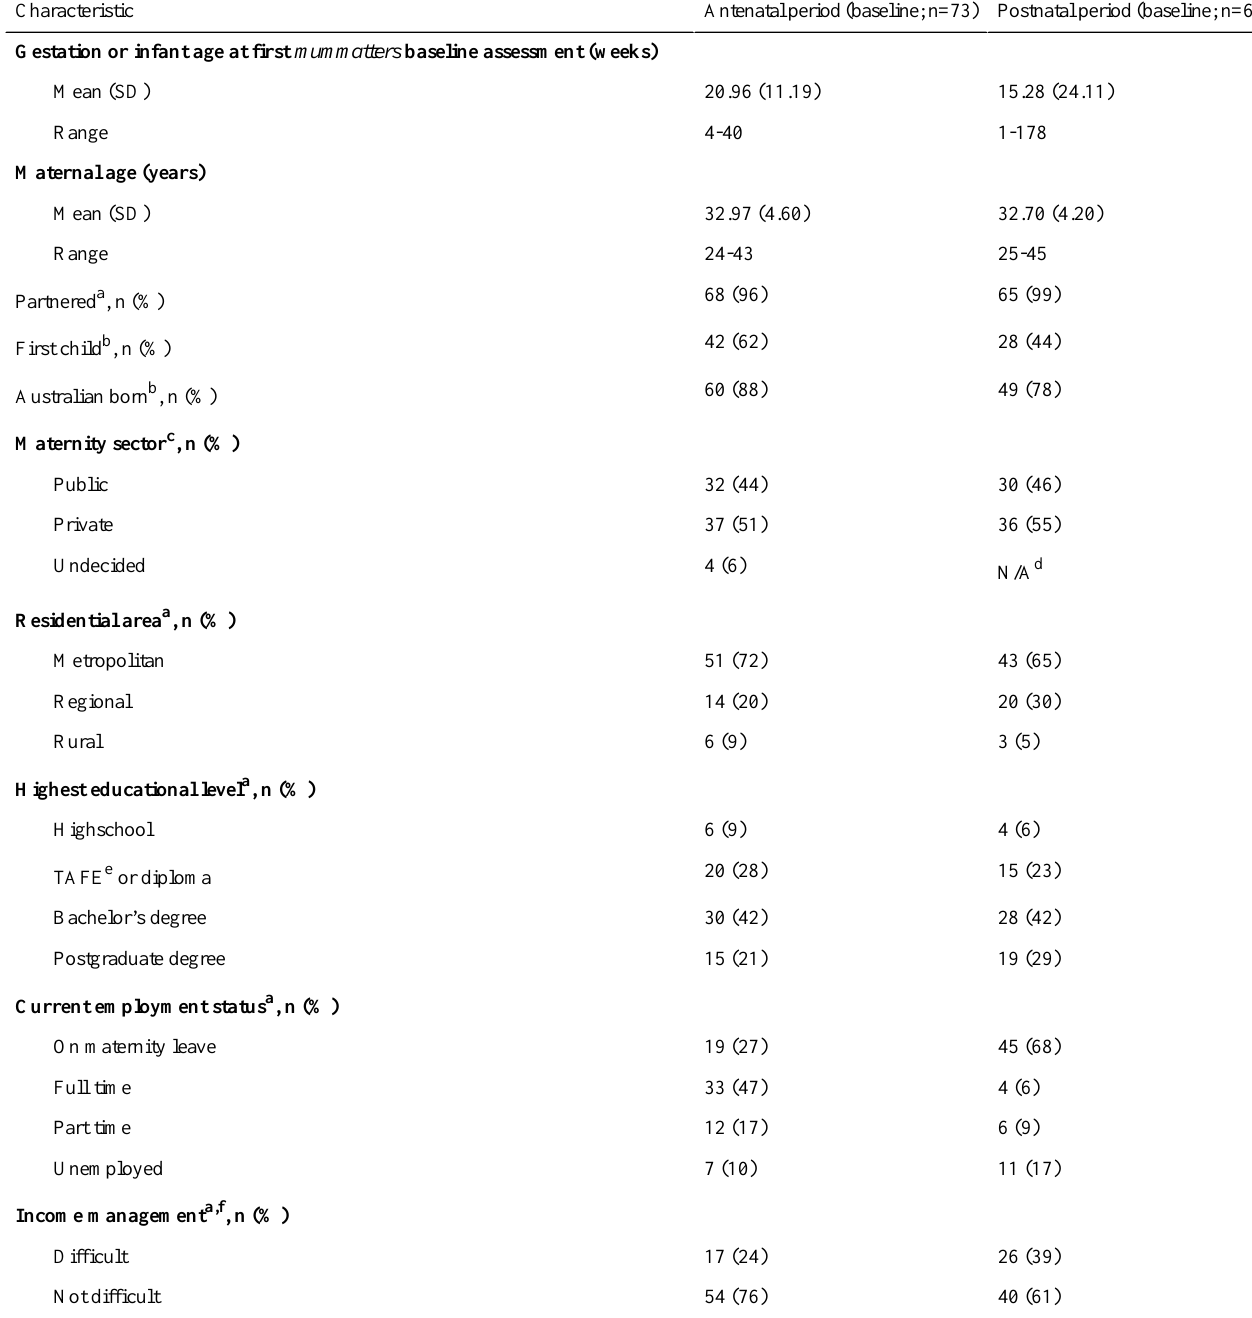
Table 1. Sociodemographic characteristics of mummatters evaluation